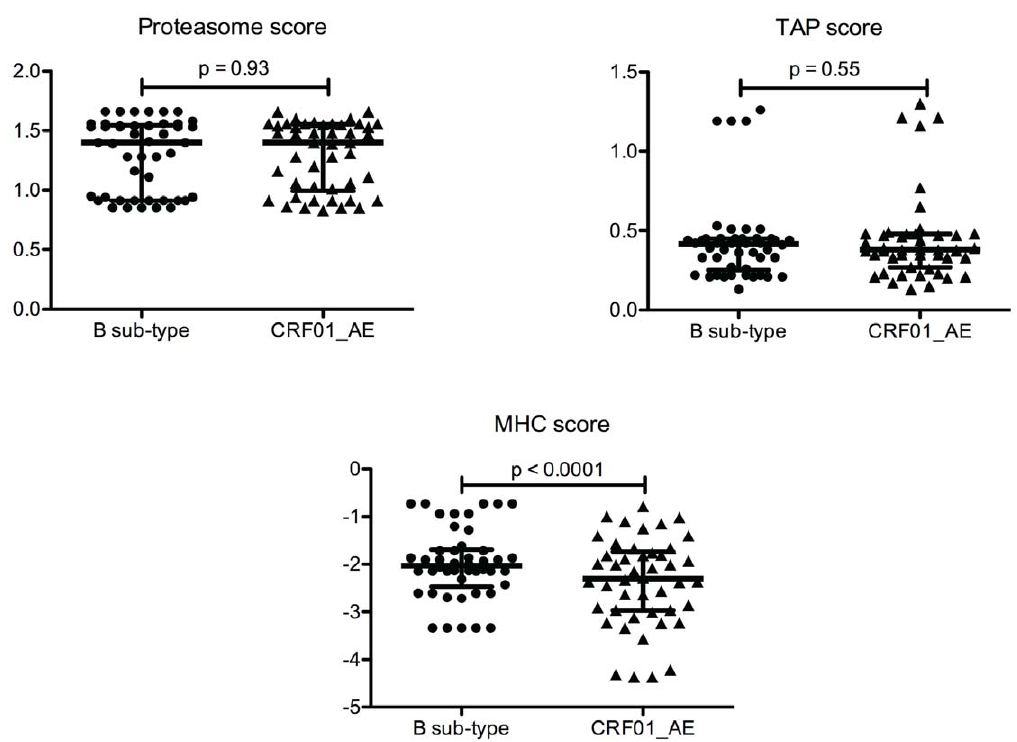
Figure 5. Comparisons of proteasome, TAP and MHC scores between wild-type (B sub-type) and divergent epitopes (CRF01_AE sequences). All scores are logarithmic values, high values corresponding to highly predicted efficiency.